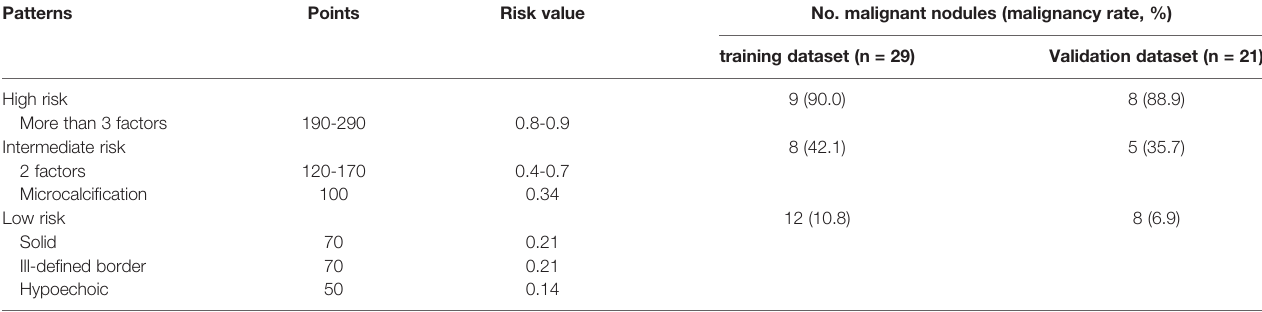
TABLE 4 | Risk strati fi cation model for thyroid nodules > 4